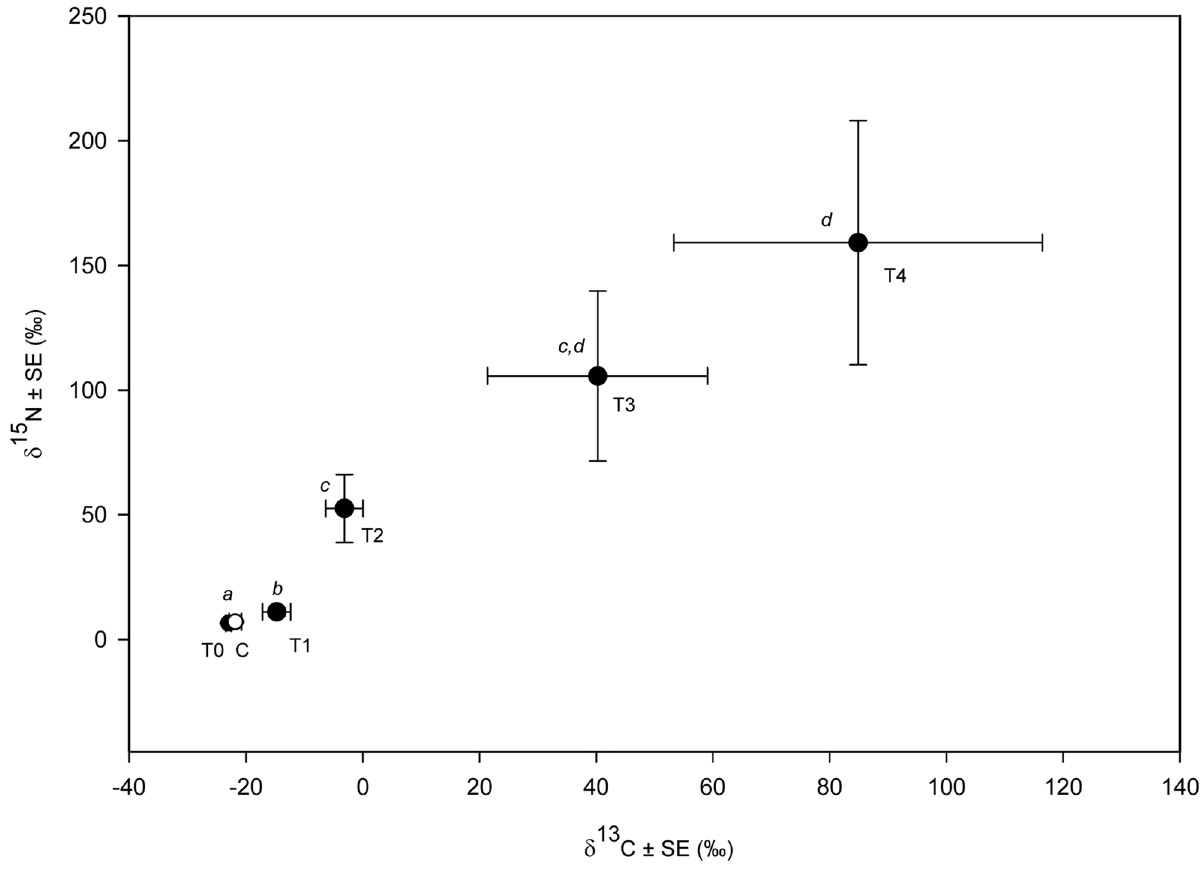
Figure 2. Temporal changes in d 13 C and d 15 N values of P.erythodactyla fed enriched mangrove leaves. Shown in the plot are the mean d 13 C and d 15 N values of crabs sampled at the start of the feeding experiment (T0, n=7), at the end of every week (T1–T4, n=8 for each sampling event), and those in the control (C, open circle, n=8). Data points marked with different italic letters are significantly different (Mann-Whitney U tests, p ,